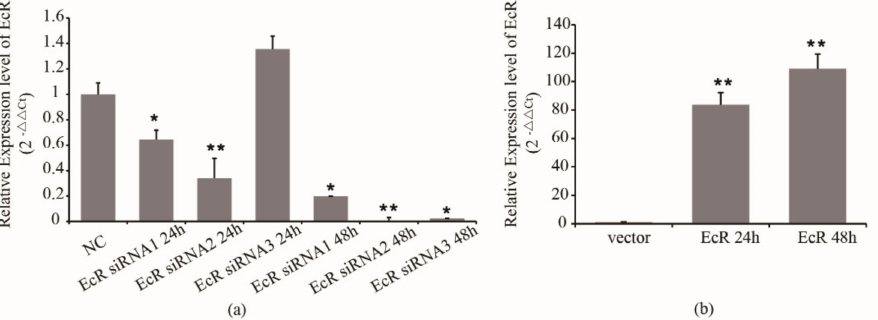
Figure 2. Effect of siRNAs and overexpressed vector on the expression of EcR. ( a ) Effect of siRNA on the expression of EcR. ( b ) Effect of overexpressed vector on the expression of EcR. * means p < 0.05, ** means p < 0.01.